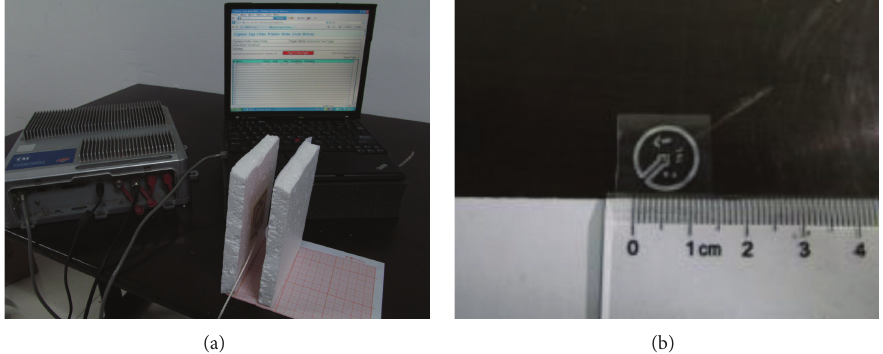
Figure 7: Antenna measurement. (a) Test scene of read range measurement. (b) Impinj UHF button near-field tag.